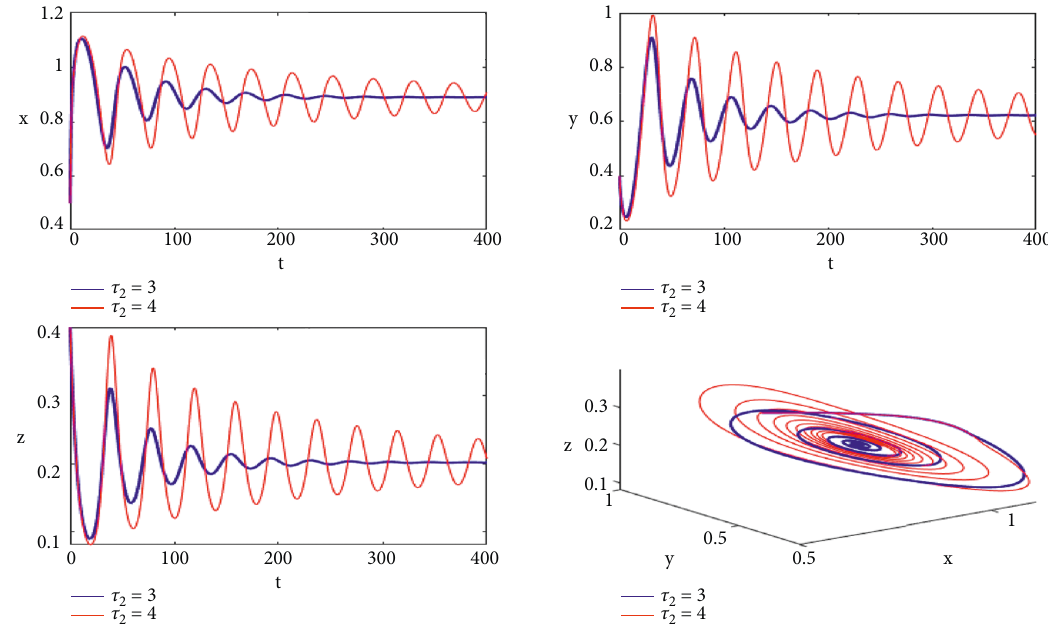
� τ � 0 and θ � 0 . 9. 1 2